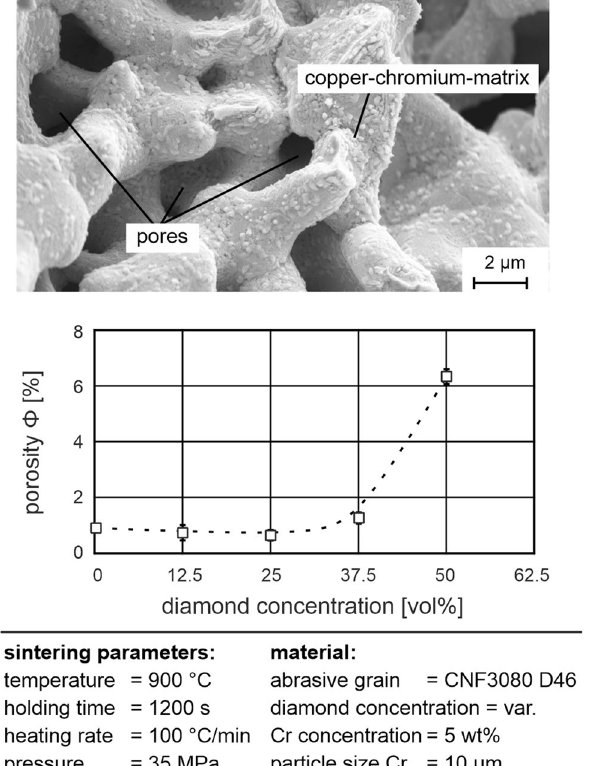
Fig. 3 Increase of porosity of the composite specimens with an increasing diamond concentration above a concentration of 37.5%. The upper image shows the pore structure of the bond matrix with a diameter of 2–5 µm at a diamond concentration of 50 vol%